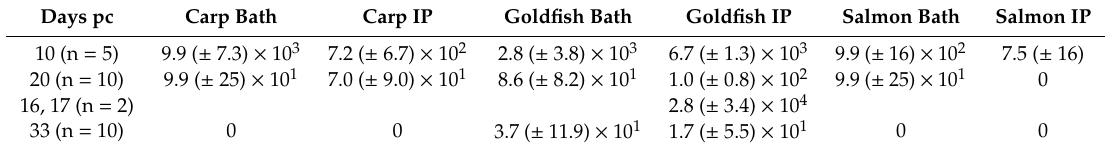
Table 5. Re-isolation of chinook salmon bafinivirus Cefas-W054 from tissue homogenates (pool of brain, kidney, heart and spleen) of common carp, goldfish and Atlantic salmon challenge using a bath challenge (bath) or intraperitoneal (IP) injection. Titers measured in E11 cells incubated at 20 ◦ C and are expressed as TCID 50 mL − 1 . pc: post-challenge, n: number of sampled animals per group. Two moribund fish were recorded at 16 and 17 days pc.